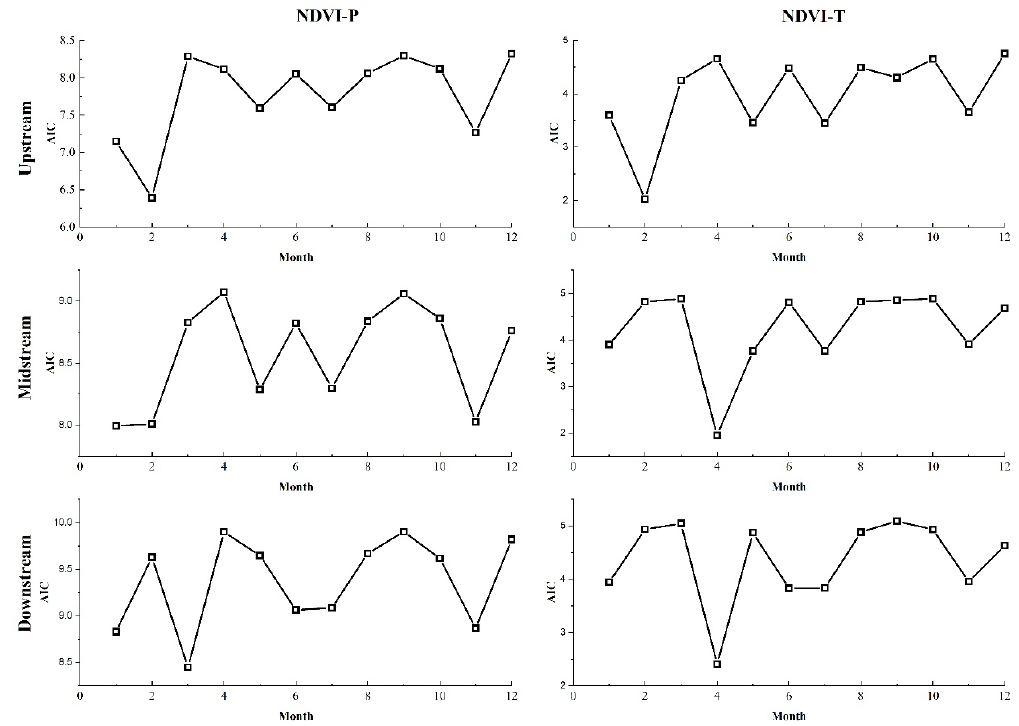
Figure 6. Lag length of NDVI-T and NDVI-P in the three sub-watersheds Table 4. The Granger causality test results for different sub-watersheds at the optimal lag length. Sub-Watershed Optimal Lag Length H 0 (Null